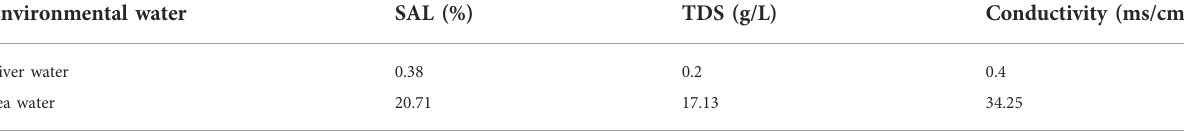
TABLE 4 Salinity, total dissolved solid (TDS) and conductivity of environmental water